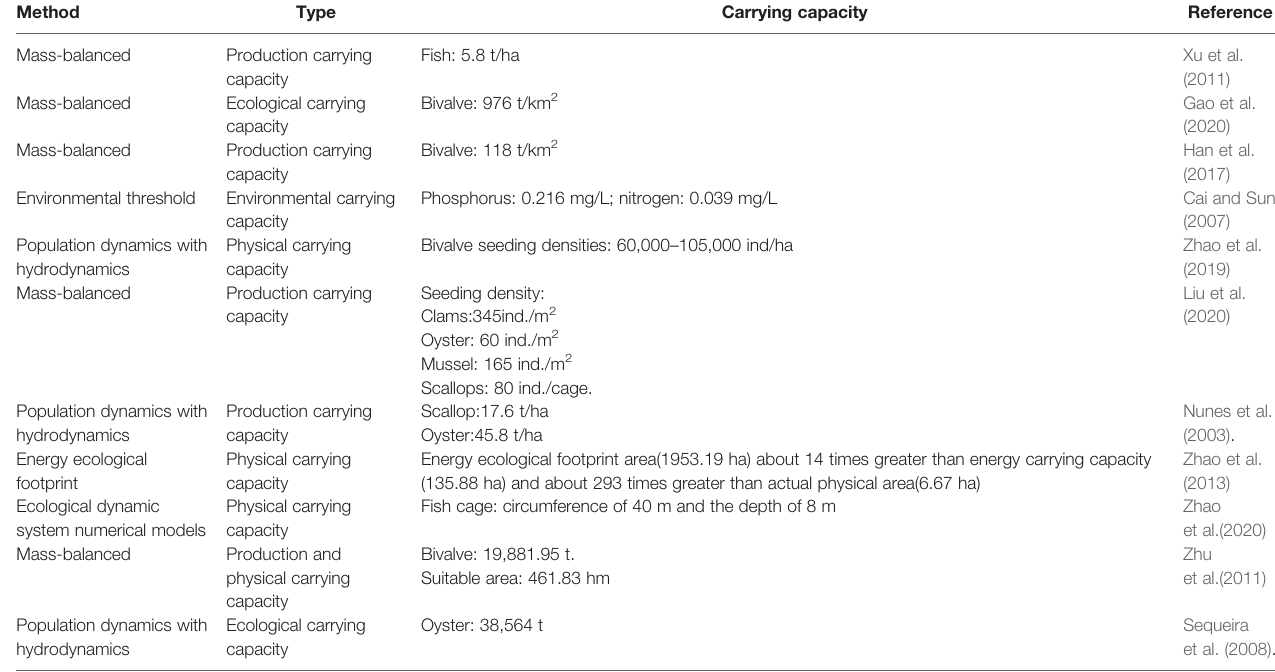
TABLE 2 | Carrying capacity assessment of mariculture in